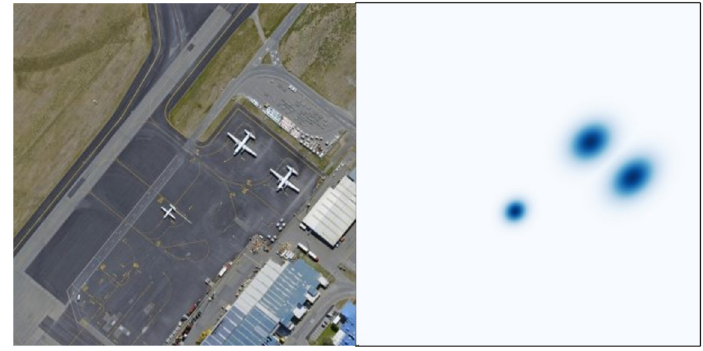
Figure 6. Spatial attention module.